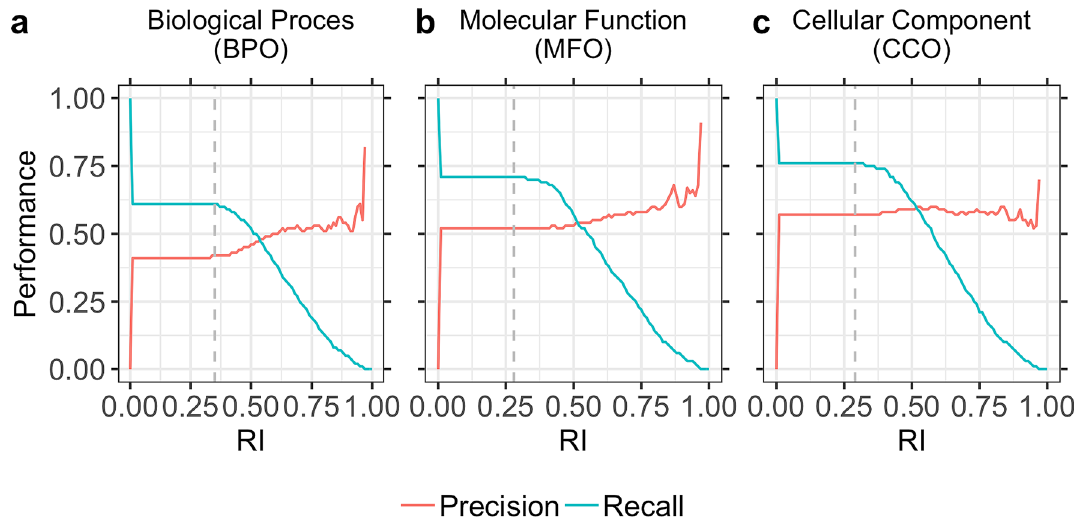
Figure 3. Precision and recall for different reliability indices (RIs). We defined a reliability index (RI) measuring the strength of a prediction (Eq. 5), i.e., for the embedding proximity. Precision (Eq. 1) and recall (Eq. 2) were almost constant for lower RIs (up to ~ 0.3) for all three ontologies (BPO, MFO, CCO). For higher RIs, precision increased while recall dropped. However, due to the low number of terms predicted at very high RIs (> 0.8), precision fluctuated and was not fully correlated with RI. Panel ( a ) shows precision and recall for BPO, panel ( b ) for MFO, and panel ( c ) for CCO. Dashed vertical lines marked the thresholds used by the CAFA3 tool to compute F max : 0.35 for BPO, 0.28 for MFO, and 0.29 for CCO. At least for BPO and MFO higher RI values correlated with higher precision, i.e., users could use the RI to estimate how good the predictions are likely to be for their query, or to simply scan only those predictions more likely to be correct (e.g. RI >